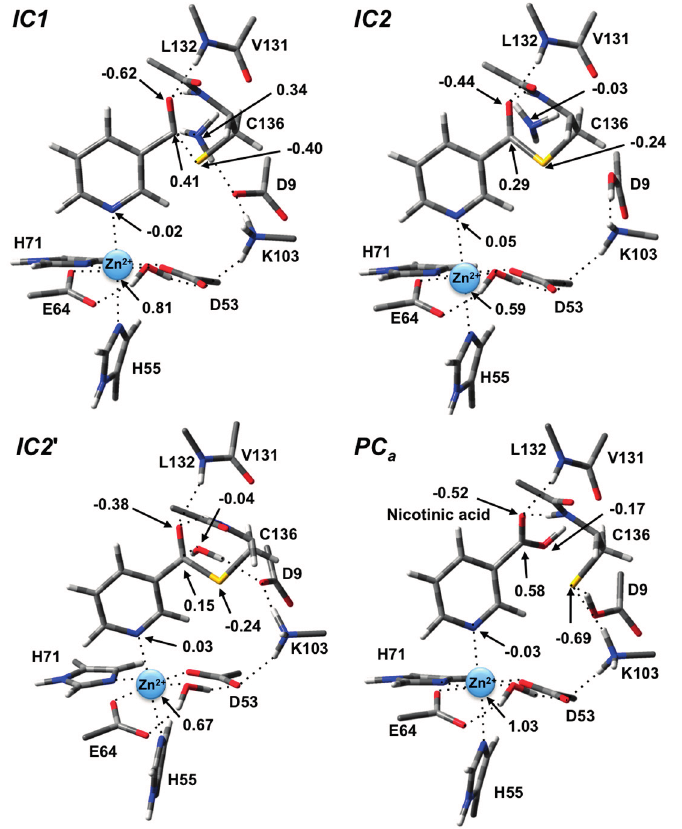
Figure 4. ESP charges for select key species in the SpNic mechanism (H-atom